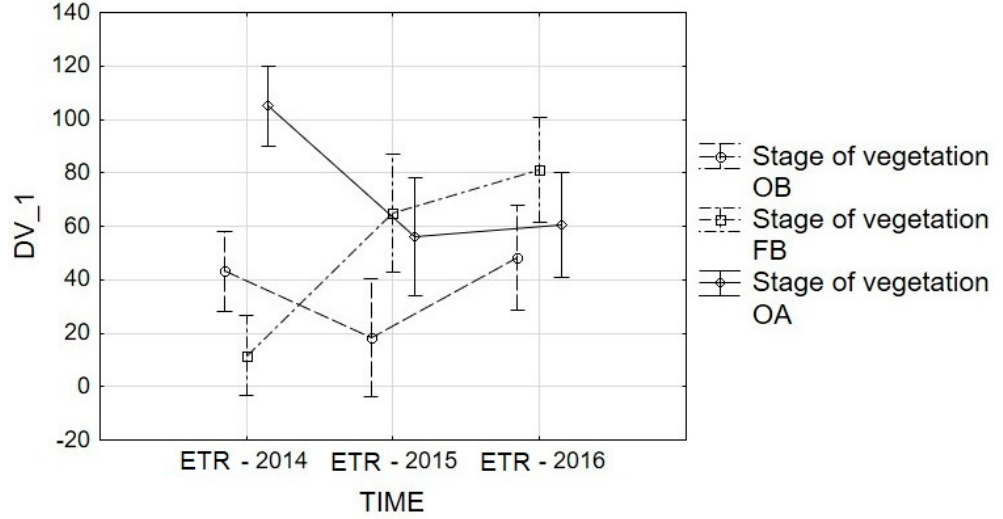
Figure 8. Repeated-measures ANOVA for ETR: interaction graphs for time and stage of vegetation. Vertical bars denote 0.95 confidence intervals. Estimated Marginal Means: TIME*Stage of vegetation. F(4, 270) = 10.946, p = 0.00. Stages of vegetation: OB, onset of budding; FB, full budding; OA, onset of anthesis.